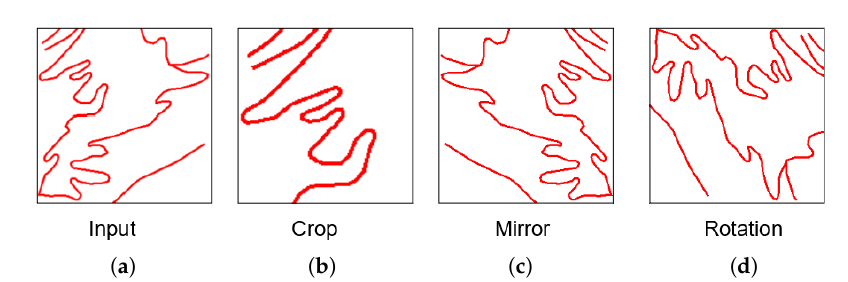
Figure 5. Augmentation methods. ( a ) Initial image. ( b ) Crop result. ( c ) Mirror result. ( d ) Rotation